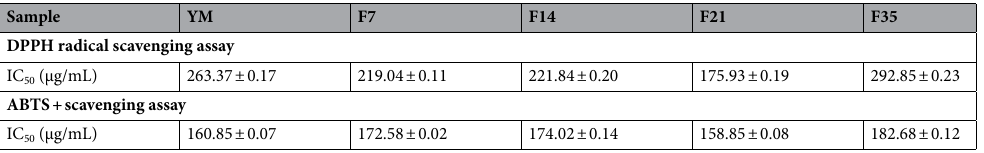
Table 3. Values of IC50 of DPPH and ABTS for Yerba Mate extract and ferments after 30 min of exposure (for DPPH method). Values are means ± standard deviation (SD) of triplicate.